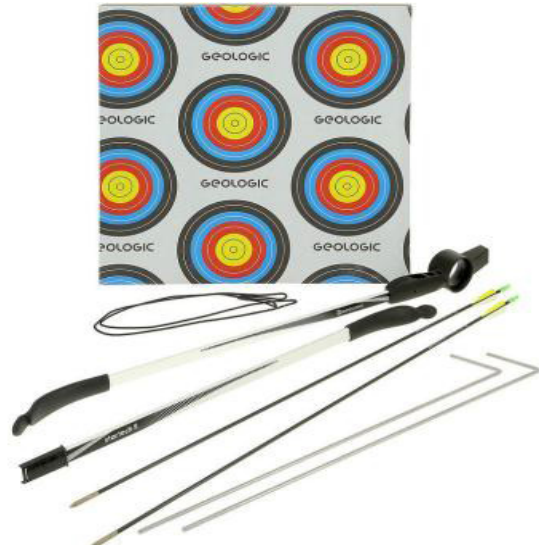
Figure 4. Geologic Startech 2 detachable bow - designed for high performance in the sport of